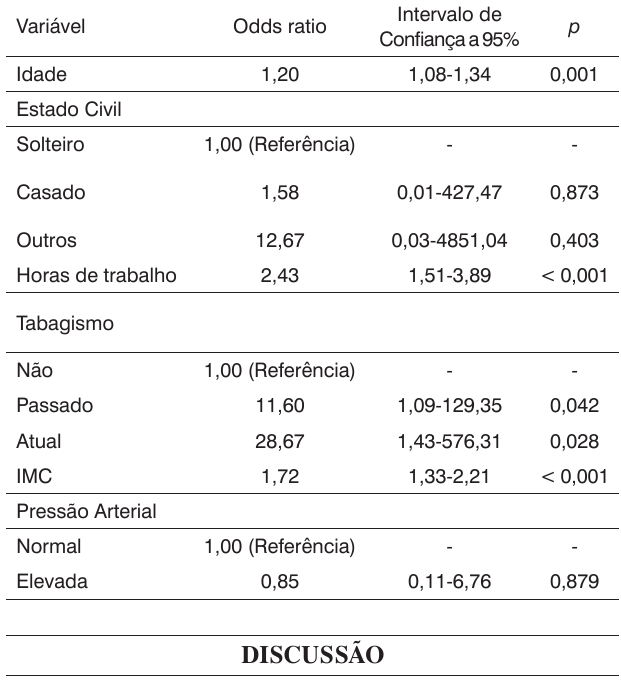
Tabela 2. Características clínicas dos pacientes.